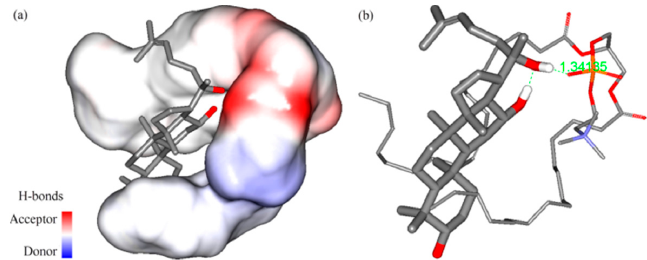
Figure 7. Initial molecular structures in the calculation. ( a ) Phospholipid; ( b ) PPD.